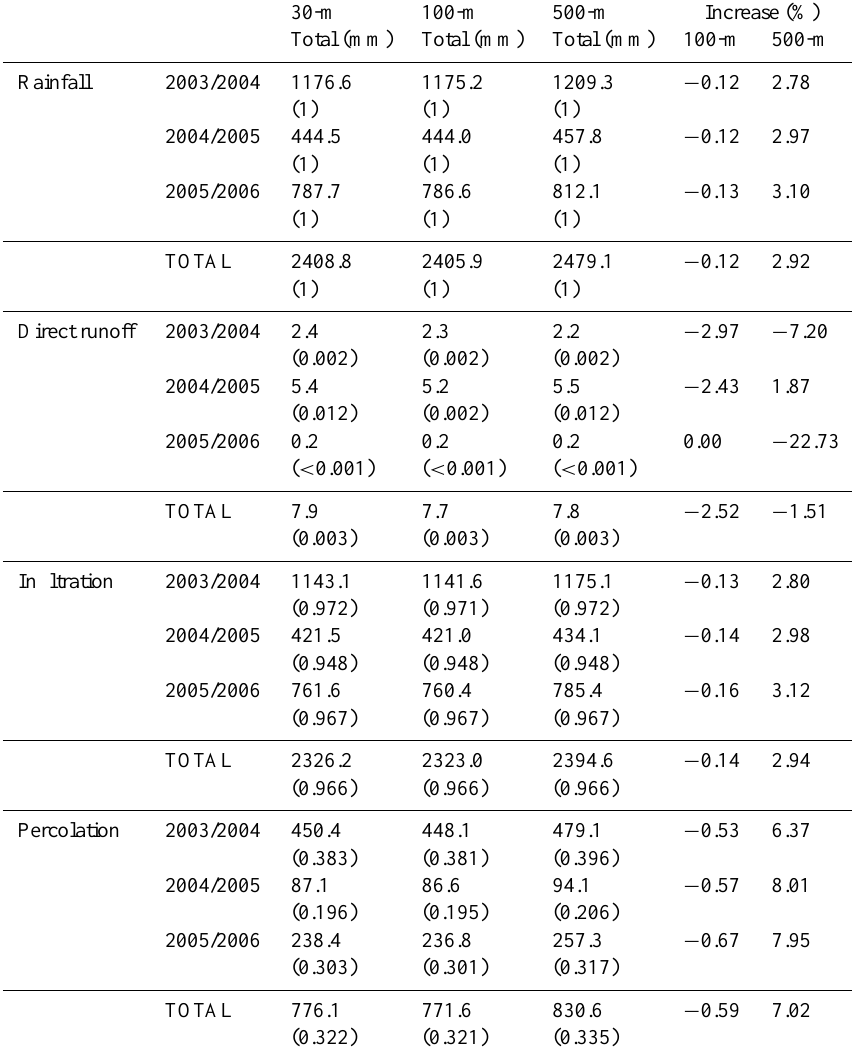
Table 3. Differences in average precipitation, direct runoff, infiltration, and percolation at the basin scale, and the corresponding rainfall fraction (in brackets), for the period 2003–2006 between different cell sizes.